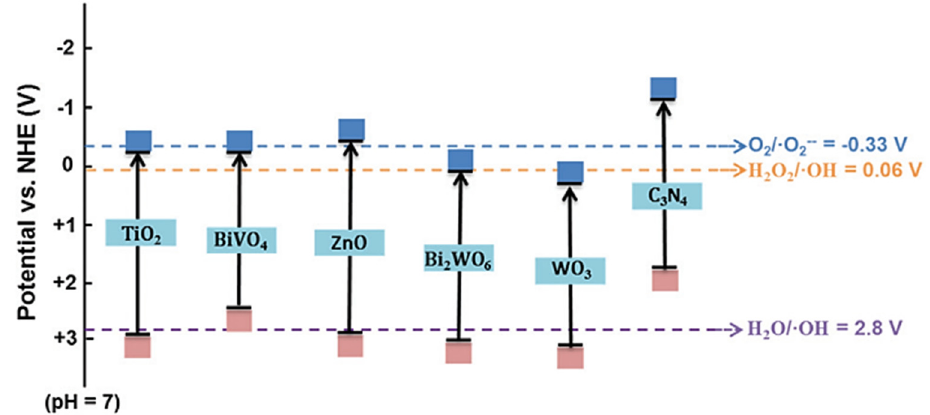
Figure 11. The valence band and conduction band position of possible photocatalyst used in methane conversion to methanol [35]. Reproduced with permission from Tian et al. Copyright © 2022 The Royal Society of Chemistry.